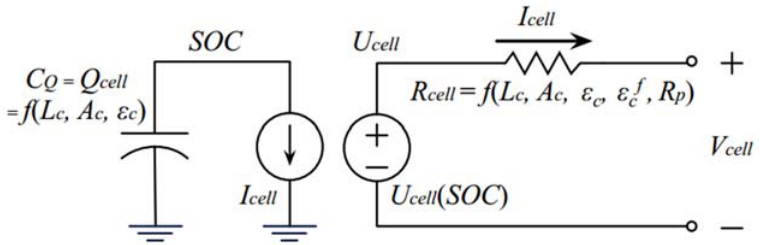
Figure 5. Equivalent circuit model showing the contributors to capacity and resistance properties. It is used for investigating the cell ‐ to ‐ cell variation. Taken from [38].